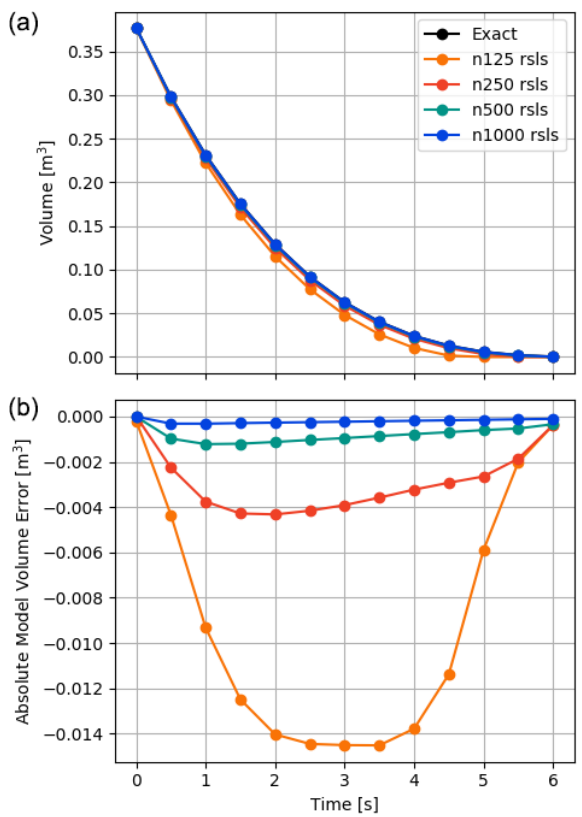
Figure 5. (a) Comparison of the exact pyramid volume decrease (black line, Eq. 14) with simulation results (coloured lines) for mesh resolutions N = 125 , 250 , 500 , 1000. The term “rsls” indicates the usage of reduced-space methods to solve the variational inequality. Panel (b) shows the absolute difference between the exact solution and simulation results to demonstrate convergence as the mesh res- olution